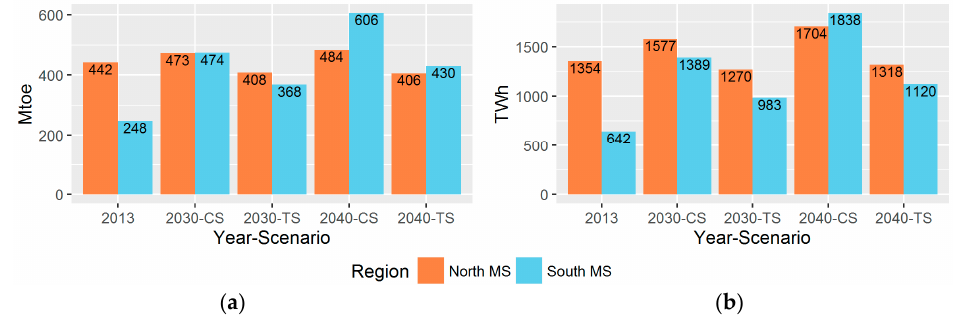
Figure 10. ( a ) Total energy consumption (in Mtoe) of the Northern and Southern Mediterranean Sea; ( b ) Electricity generation (in TWh) of the Northern and Southern Mediterranean Sea. Data obtained from [133].